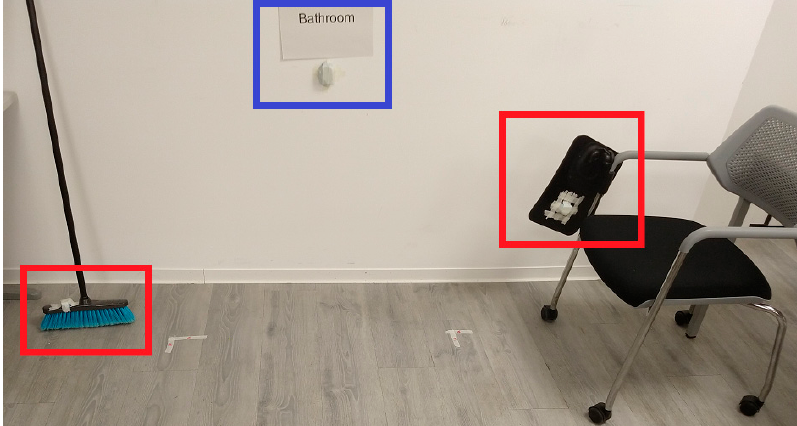
Figure 2. Example of types of beacons. Beacons in red squares are active. The beacon in the blue square is stationary.